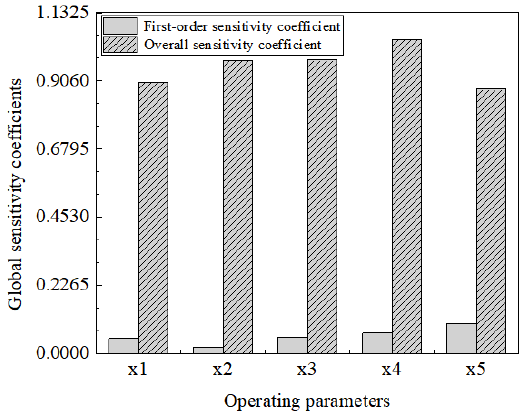
Figure 9. Global sensitivity coefficient of operating parameters.